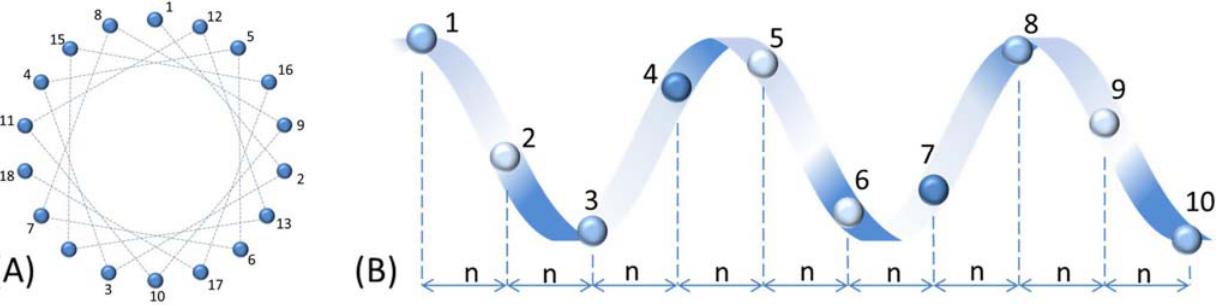
Figure 1. Schematic representation of an α -helical AMP. This figure assumes the same α -helix propensity for all amino acids in the peptide structure. ( A ) Helical wheel projection of the AMP (top view). The angle between two consecutive amino acids in the sequence is 100 degree. Dotted lines show two adjacent amino acids in the primary structure. ( B ) Side view of the peptide. The distance between two adjacent amino acids, “n”, is 0.15